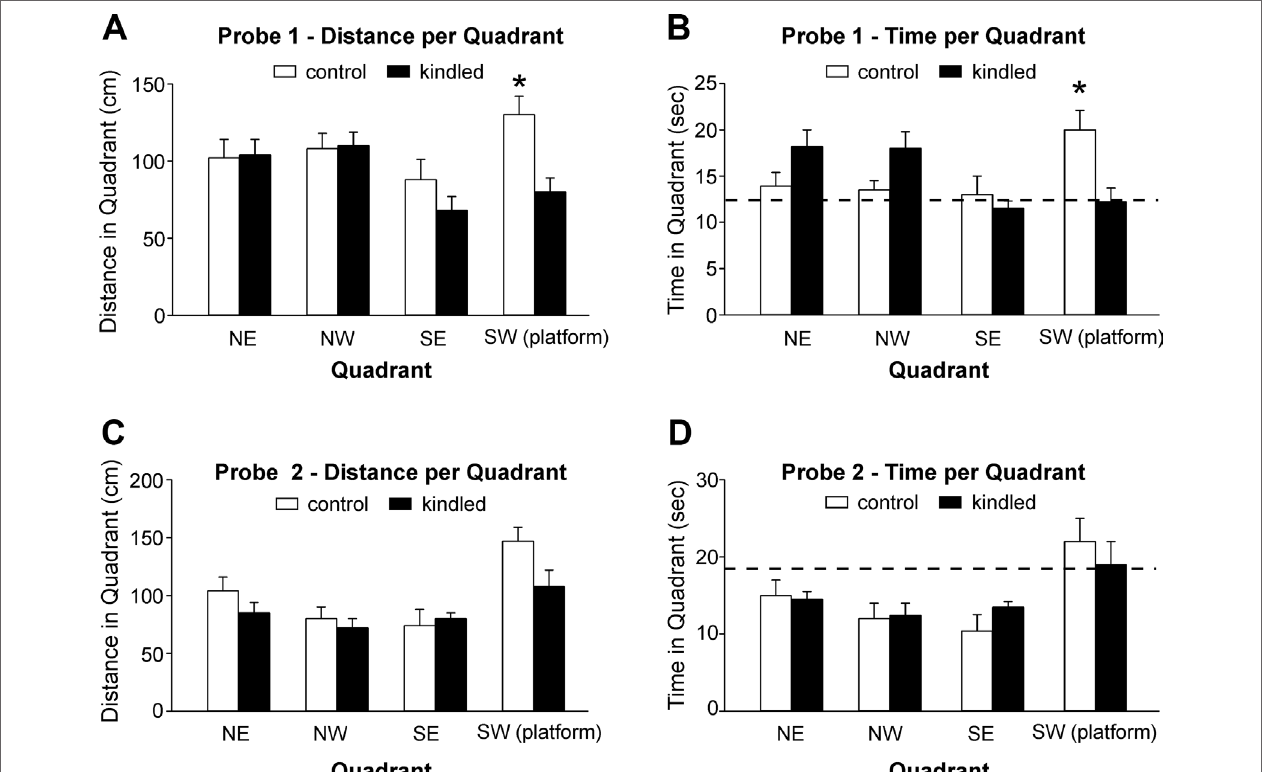
FIGURE 3 | Measures for probe tests. Data (means ± SEM) were collected from the extended kindled and handling control mice (n = 12 each group). (A , B) Distances traveled and time spent in each of the quadrants during the first probe trial. (C , D) The same measures collected during the second probe trial. Dotted lines represent chance performance. Note that the kindled mice traveled shorter distances and spent less time in the correct quadrant as compared to the controls. Significant differences between the control and extended kindled mice were denoted by